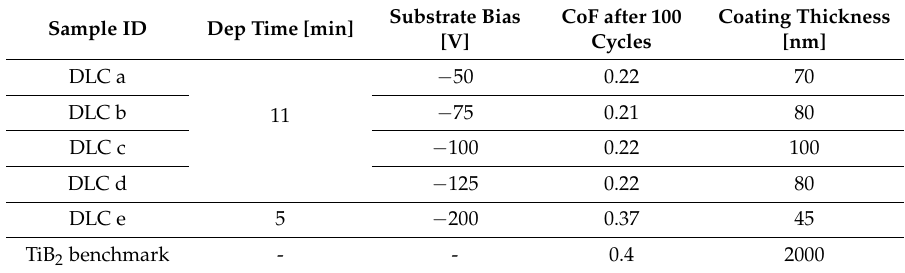
Figure 2. SEM images of coatings’ cross sections prepared using focused ion beam (FIB). Table 2. Monolayer diamond-like carbon (DLC) deposition times, bias and thickness.